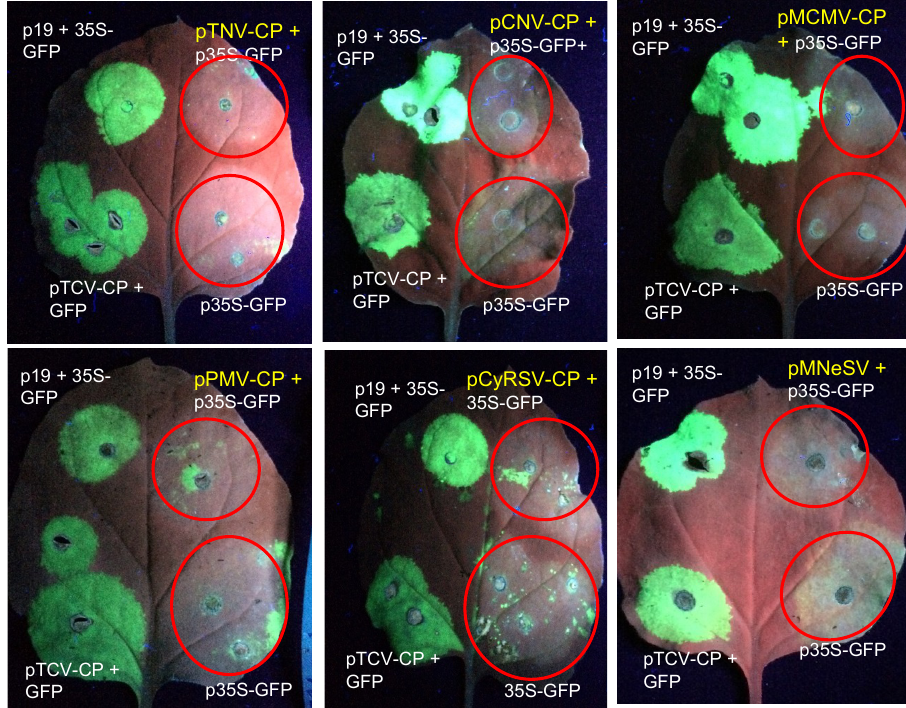
Figure 6. Agroinfiltration of p35S-GFP alone or co-agroinfiltration with virus CP clones or TBSV p19. The clones pTCV-CP and TBSV p19 were included in each leaf as positive controls for silencing suppression, whereas p35S-GFP was included in each leaf to illustrate the induction of the host silencing response. The zone of infiltration is highlighted in tissues that did not exhibit silencing suppression. Photos were taken under UV illumination between 8–10 dai.